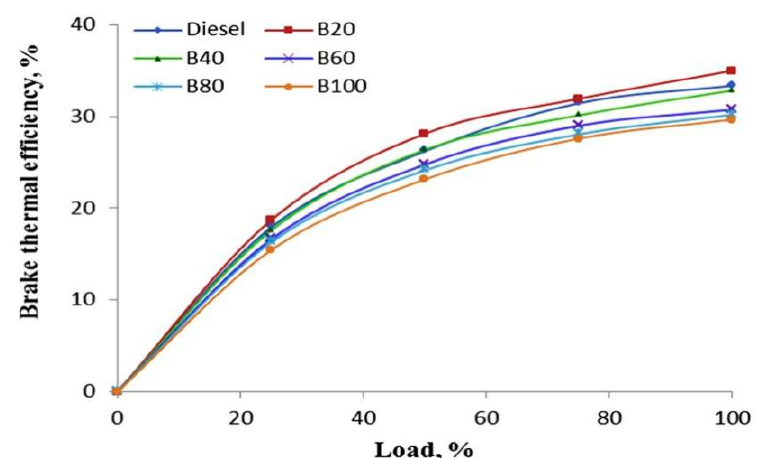
ffi ciency of fish oil biodiesel blends with load at 21 ◦ bTDC Figure 3. Variation of brake thermal efficiency of fish oil biodiesel blends with load at 21°bTDC [33]. Figure 3. Variation of brake thermal e